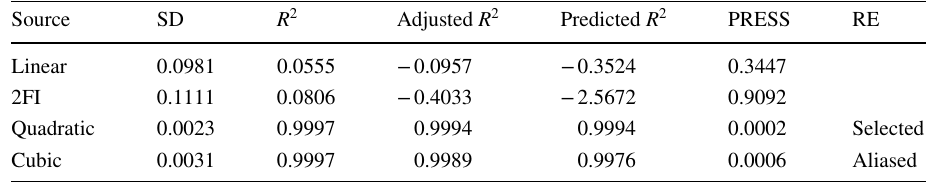
Table 6 Model summary statistics for removal of Cr(VI) on Teff husk activated